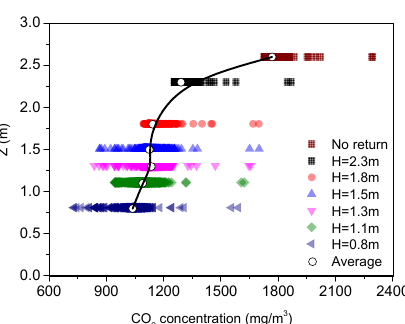
Figure 12. Comparison of frequency distribution of CO 2 concentration for seven settings at breathing level (Plane Z = 1.0).